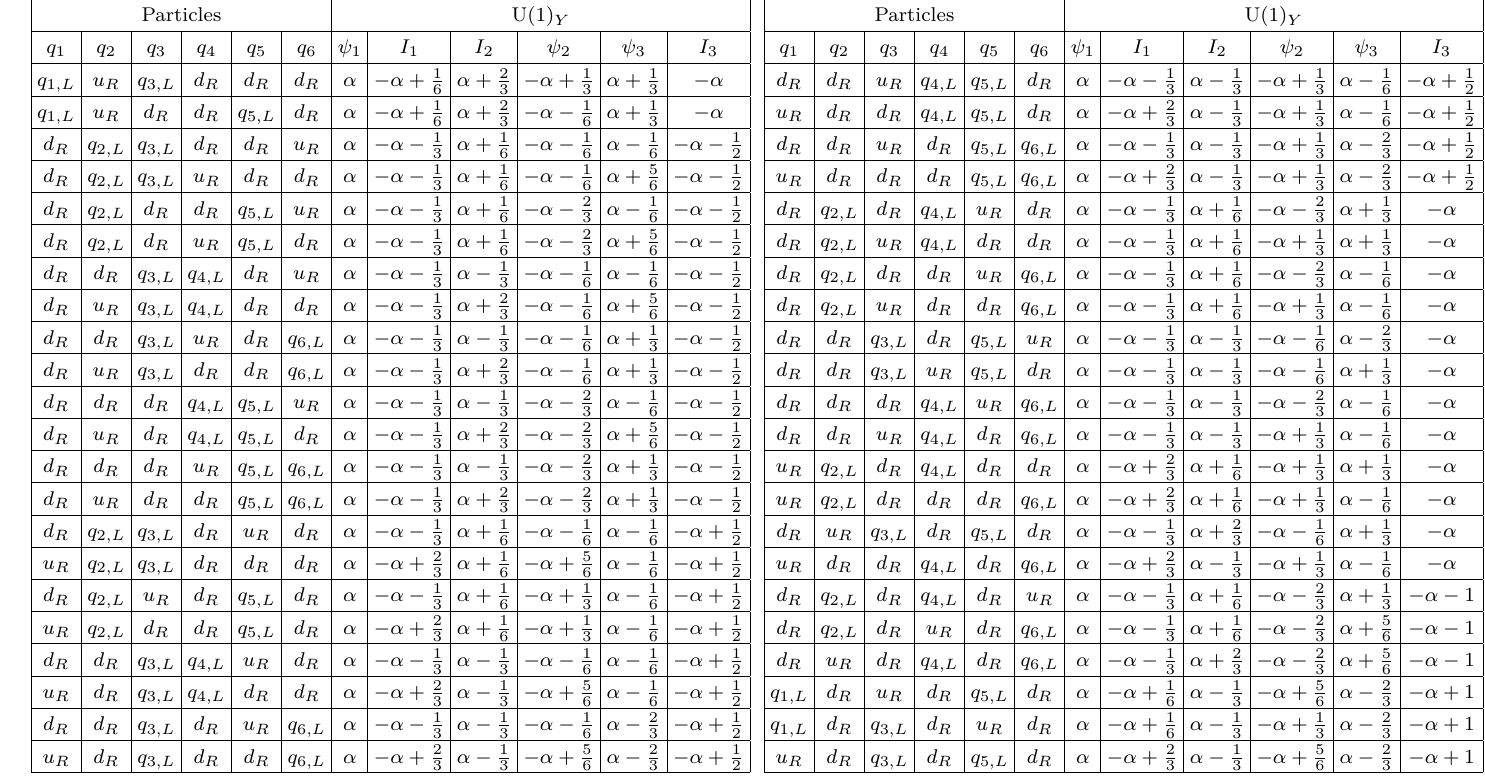
Table 14 . The possible U(1) Y numbers of the fields in